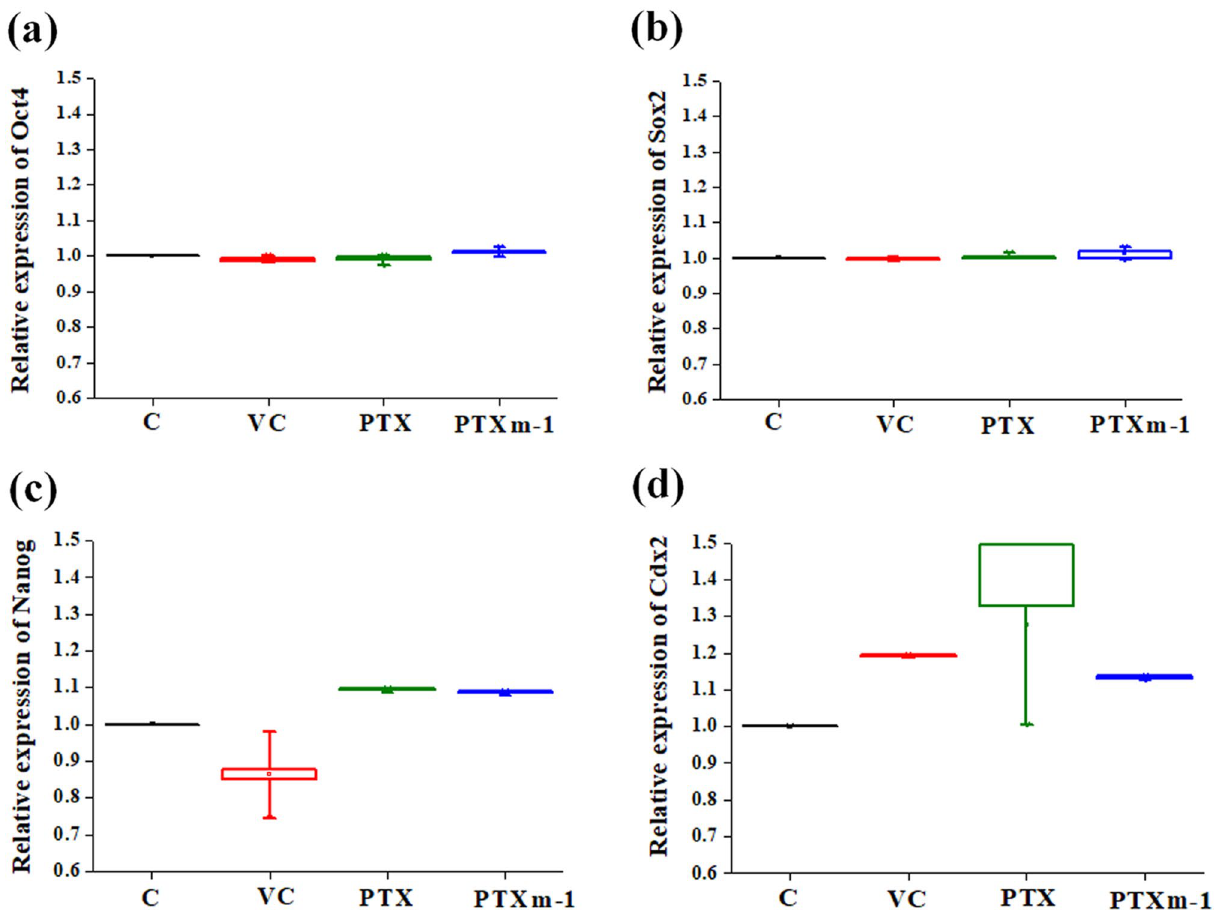
Figure 9. Effect of PTX and PTXm-1 on mRNA expression of pluripotency and trophectoderm genes in blastocysts derived from in vitro fertilized embryos from Swiss albino mice. The box and whisker plot represents median relative expression of pluripotency genes ( a ) Oct4, ( b ) Sox2, ( c ) Nanog, and trophectoderm gene ( d ) Cdx2. The error bar represents standard error to mean (N = 30 embryos each, 2 trials). C: control; VC: vehicle control; PTX: pentoxifylline; PTXm-1: modified affinity to above PDEs (Table 1) . The presence of PTXm-1 caused ~ eight-fold decrease in the binding affinity of PTX towards PDE10A, indicating that PTXm-1 may bind in the same or overlapping site as PTX (Supplementary Fig. S1). Finally from weak binding affinity of PTX to PDEs we infer that PTX could not be a potent inhibitor of these enzymes. Therefore, with a view to designing a better inhibitor against PDEs, we designed PTX analogues and performed in silico screening using docking and MD simulation studies. Crystal structure of PDE4A-PTX complex 35 showed that there are two prominent regions in the binding pocket: one which is rich in aromatic residues and the other one is rich in polar residues (Fig. 2a). Based on this and the surplus volume of binding pocket we have used a strategy of fusing an aliphatic end of the PTX with a naphthalene ring, surmising that a naphthalene ring and a purine ring could bind to the hydrophobic rich and the polar rich regions, respectively. We have also optimized the linker region between the two rings such that both ring structures should optimally bind to corresponding regions in the binding pocket. Docking, MD simulation and computational ΔG bind analy- ses of PTX analogues and a comparison with parent PTX molecule indicated that redesigned PDEIs are more potent than PTX. The designed PTX analogues exhibited lower ΔG bind compared to PTX (Table 1) suggesting that the designed PTX analogues may bind tighter to PDEs compared to PTX (Table 1), and could be more effective than PTX in modulating sperm properties which could be conducive for ART. Further, thorough in silico approach, we have designed suicidal inhibitors against PDEs, these terminal inhibitors could be more potent in inhibition of PDE catalytic activity compared to respective reversible inhibitors. We have chosen PTXm-1 (modified pentoxifylline) for ex vivo studies on sperm to know whether sperm properties modulating ability of PTXm-1 are better than PTX. Data from ex vivo studies have demonstrated that PTXm-1 was able to increase sperm motility, prolong the in vitro sperm survival (Fig. 5), improves the sperm functional competence (Fig. 8a,b and Table 3) and also fertilization potential without affecting the devel- opmental competence of the embryos (Table 4) at fourfold lower concentration compared to PTX. Overall, the beneficial effect of the parent compound (PTX) as well as the PTXm-1 on triggering the motility was similar at early intervals. However, the 24 h in vitro survival was lower in PTX exposed normozoospermic as well as